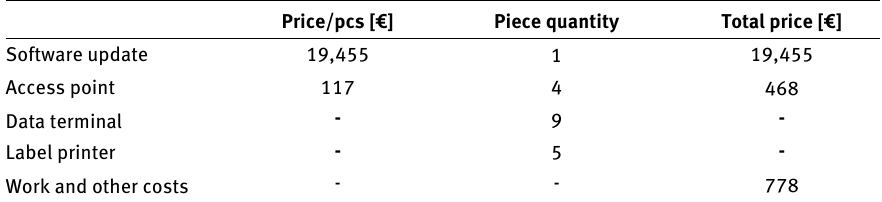
Table 1: Necessary equipment and additional costs related to the barcode implementation